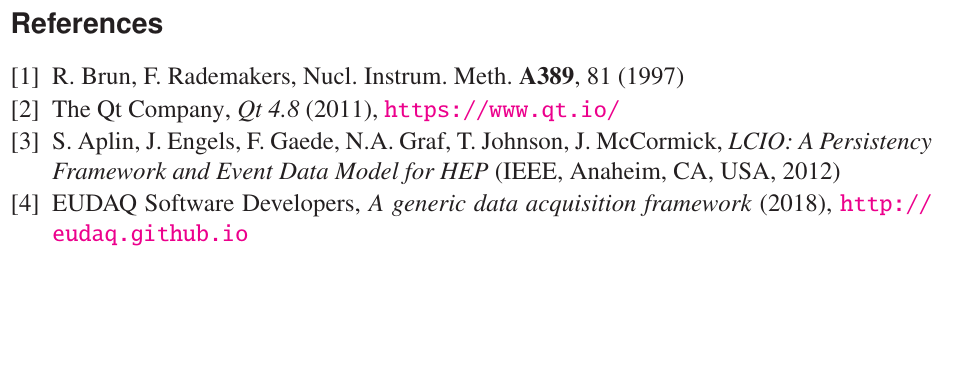
Figure 3. Main window of the monitoring GUI. 1: Option for manual / auto update of the